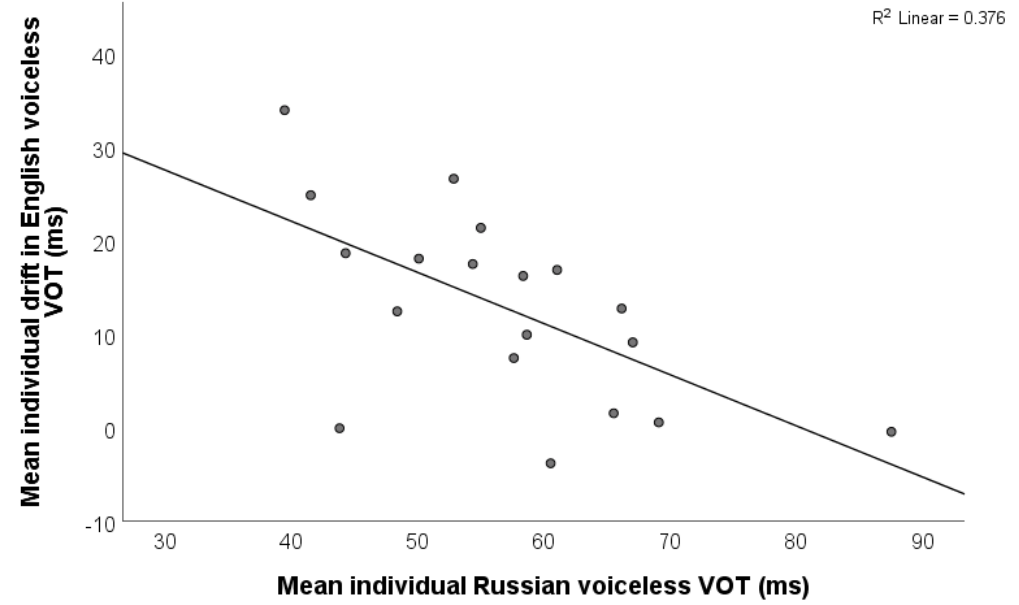
Figure 10. Correlation between individual L1 drift in English voiceless VOT (y-axis; larger values indicate greater drift towards Russian-like short lag VOT) and individual Russian voiceless VOT (x-axis).